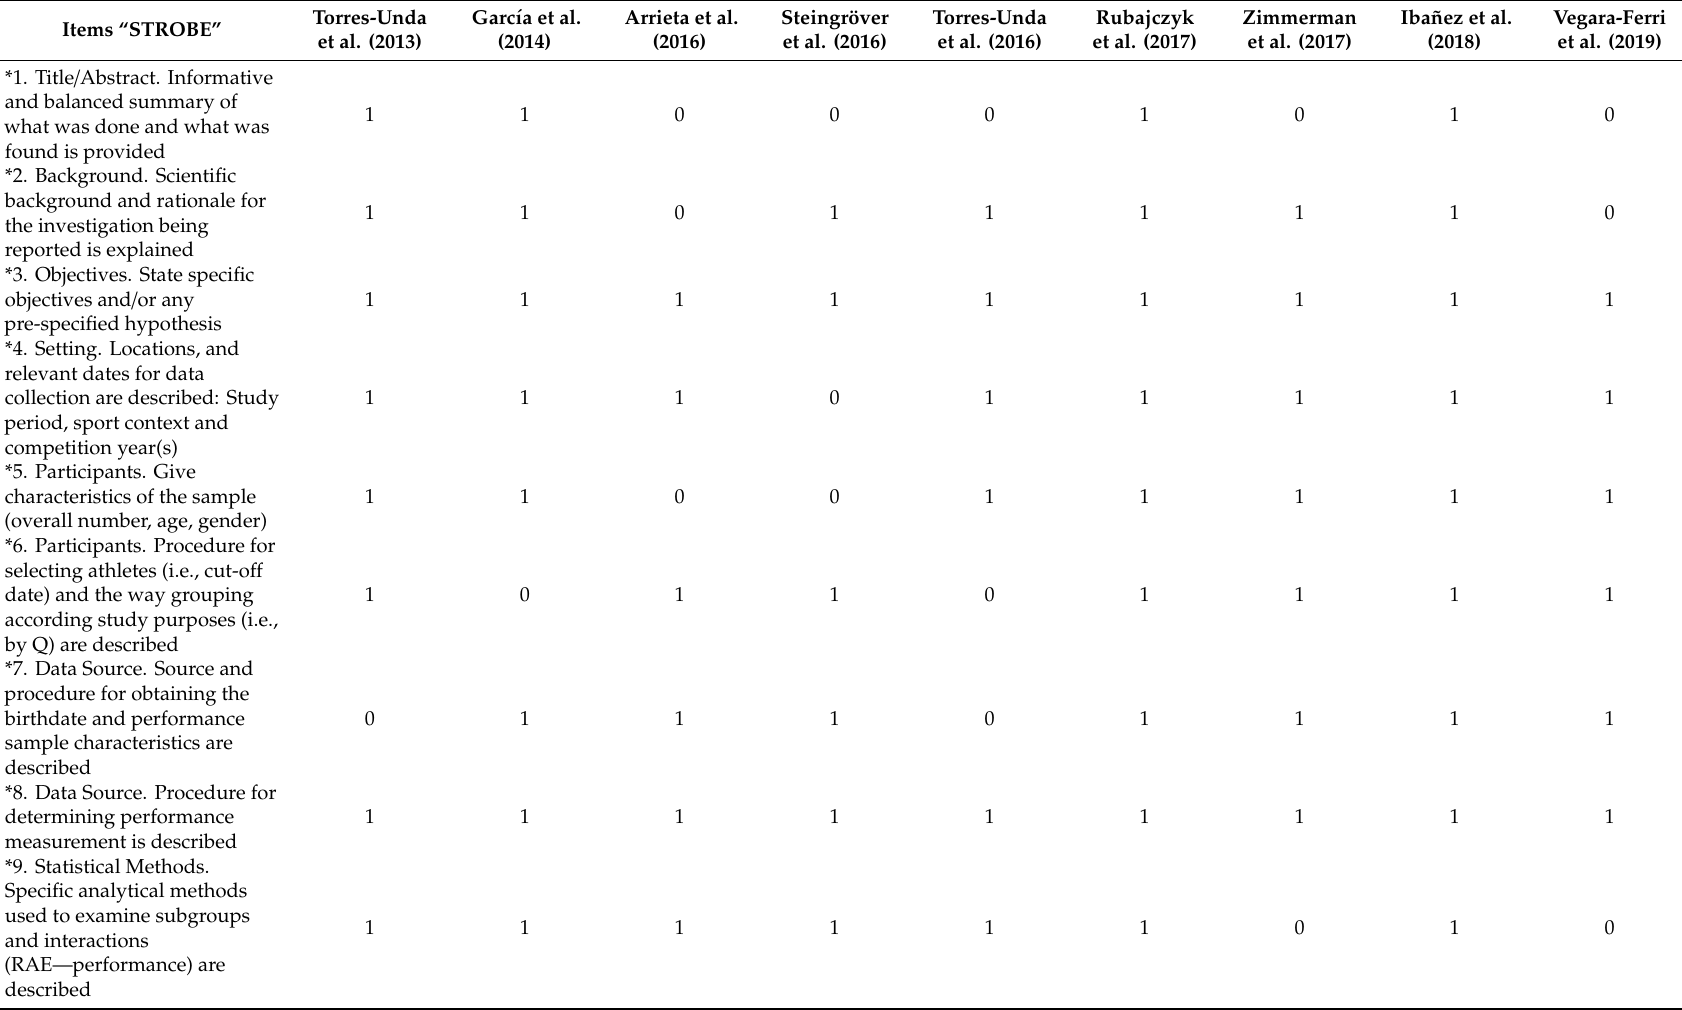
Table 6. Study quality assessment based on the adapted version of Strengthening the Reporting of Observational Studies in